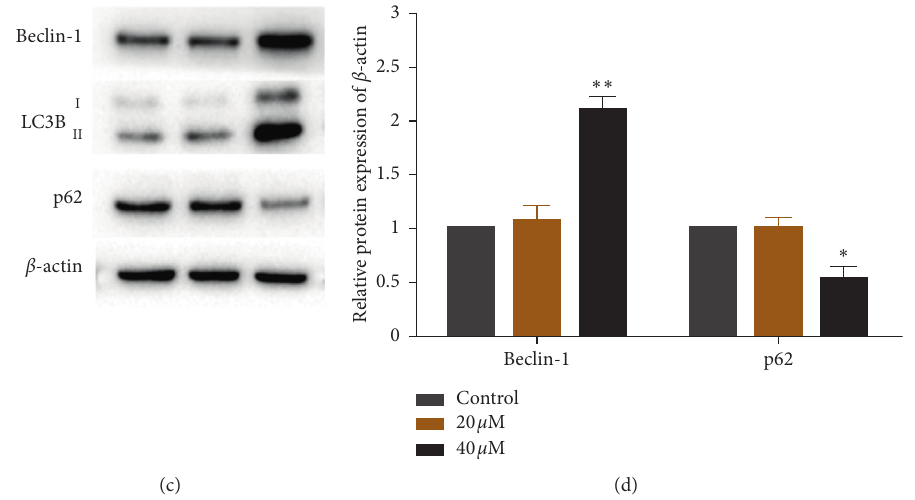
Figure 8: The expression of (a) Bcl-2 family and (c) autophagy-related proteins in Eca-109 cells treated with complex 2 for 24h. (b, d) Quantitative analysis of Western blotting from (a) and (c) by Image Lab program with β -actin as the internal control. Data were presented as mean ± SD ( n � 3), Student’s t -test, ∗ P < 0 . 05, ∗∗ P < 0 .